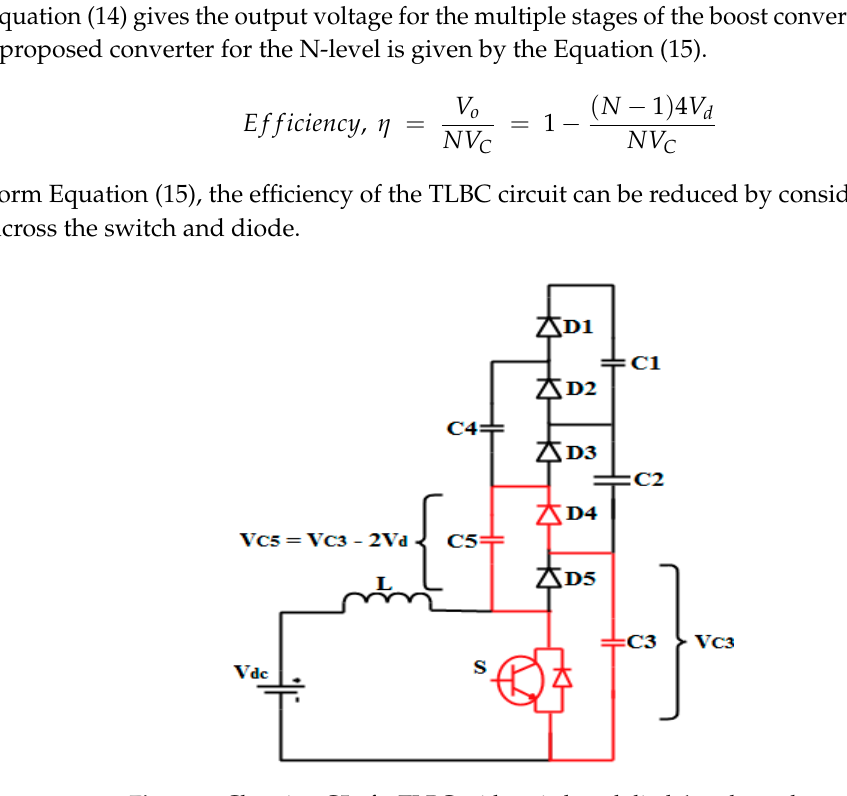
Figure 6. Model of TLBC in closed-loop mode.